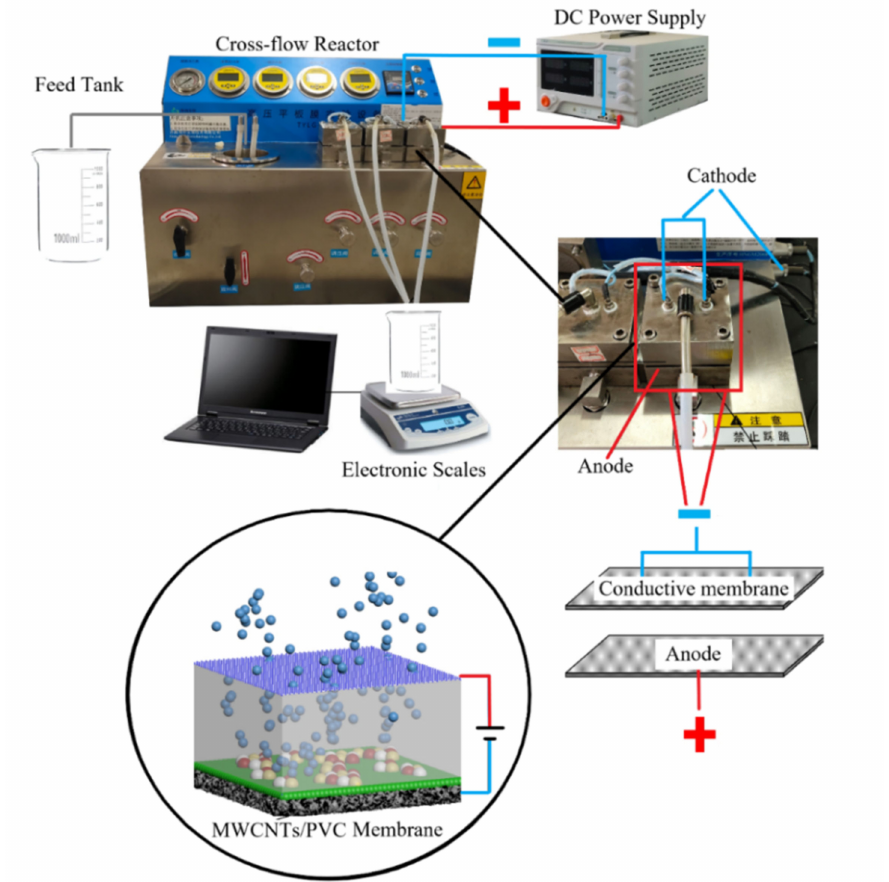
Figure 2. Schematic illustration of the membrane performance (membrane water flux, rejection, and antifouling) testing